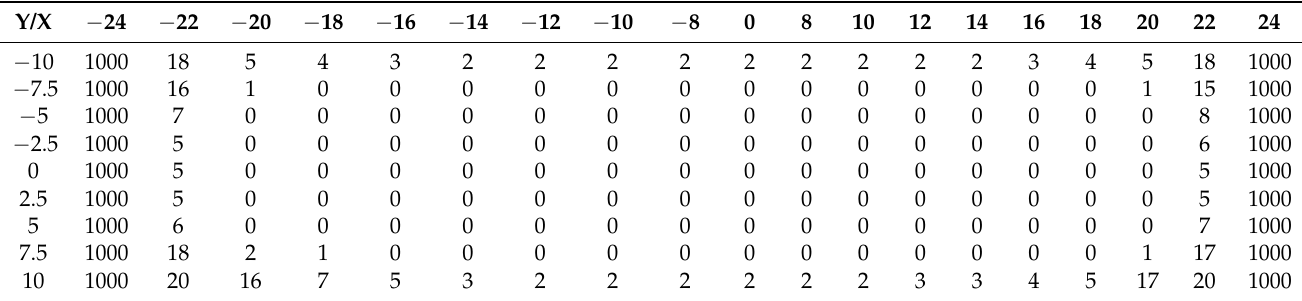
Table 3. Incorrectly transmitted messages per position.